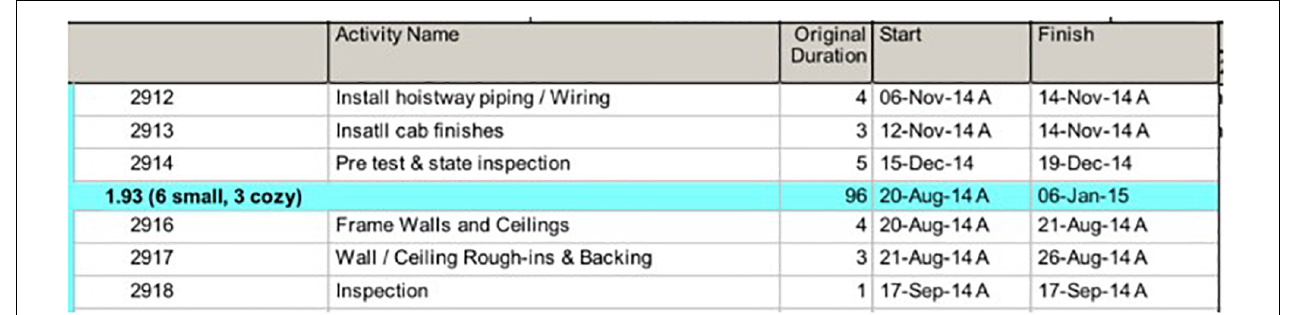
FIGURE 2 | Example of line items in the 3-week rolling lookahead schedule.